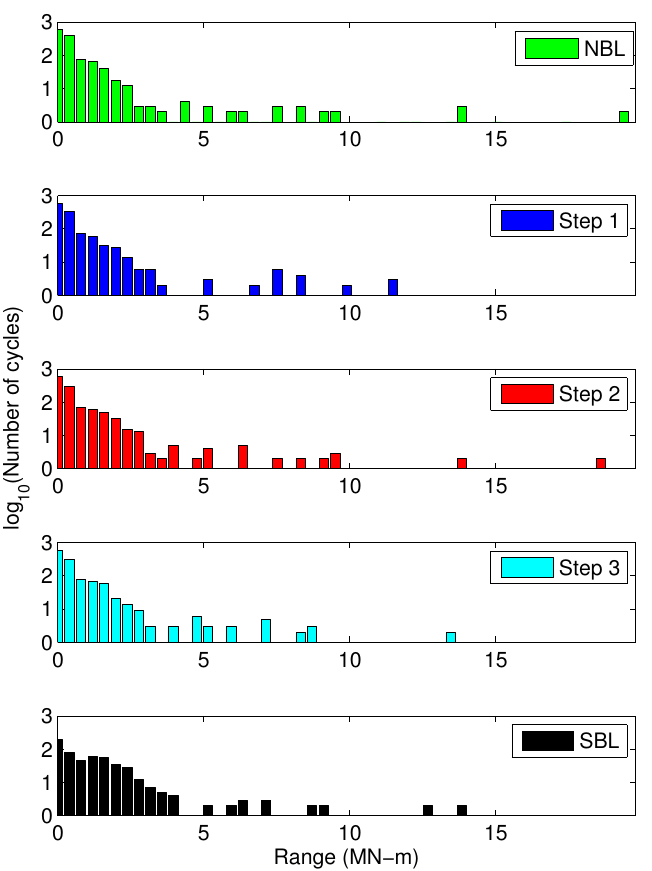
Figure 17. Comparison of FATBM range histograms for a single case